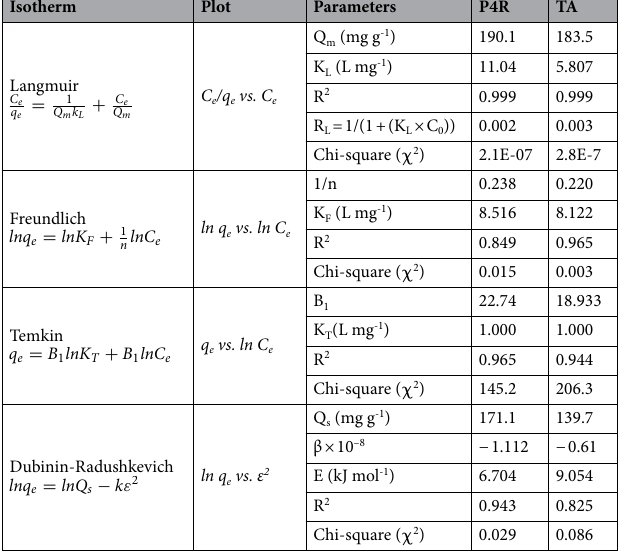
Table 4. Estimated equilibrium parameters of different isotherms for the adsorptive removal of TA and P4R dyes by